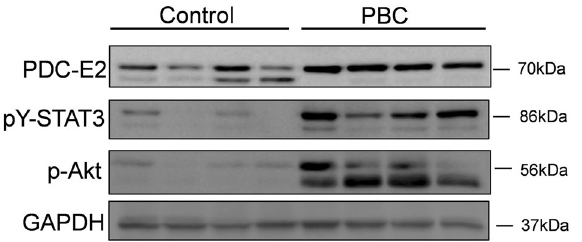
Figure 6. Presence of PDC-E2 and STAT3 in liver tissue samples derived from control and PBC patients. Immunoblot analysis of the liver tissue samples shows the presence of an additional (low-molecular weight band) of PDC-E2 protein corresponding to lower level of pY-STAT3 in control tissues whereas in cirrhotic/ PBC liver tissues, PDC-E2 was detected as single band corresponding to higher level of pY-STAT3. Level of each proteins was normalized to GAPDH as a loading